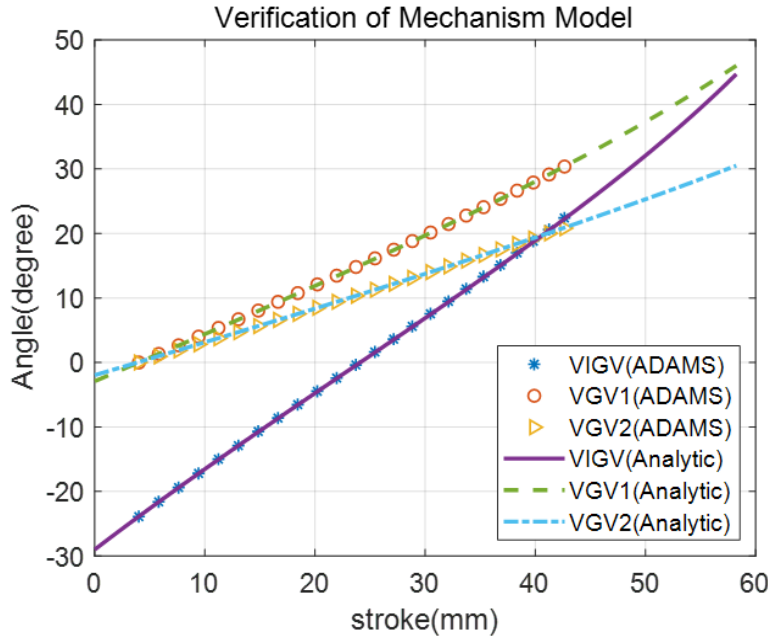
Figure 5. Verification results of the link mechanism model.